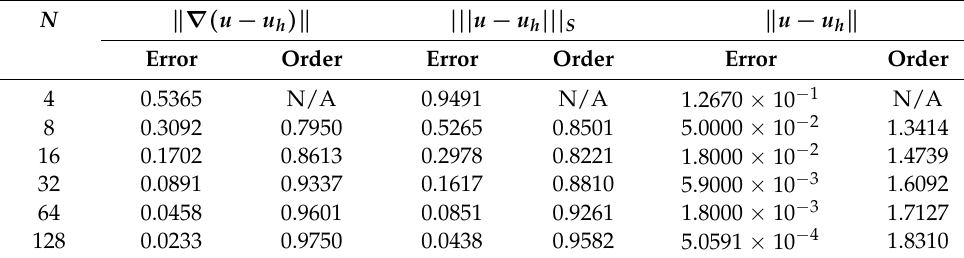
Table 5. Experiment results for the exact solution u = x 2 e y with B.C. IV.